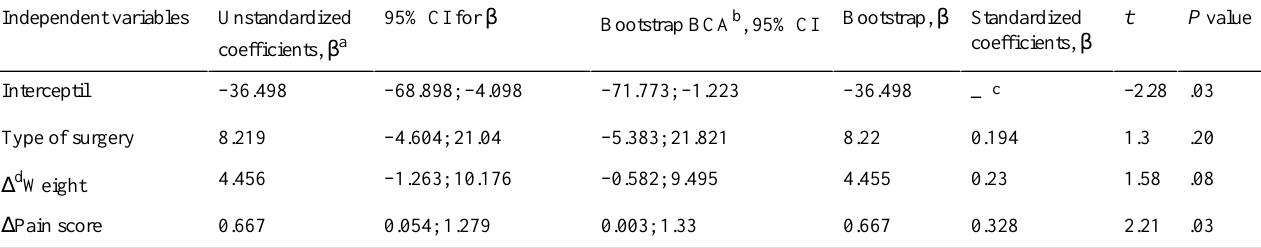
Table 4. Summary of stepwise regression analyses to determine predictors of change in IL-6 concentration ( r 2